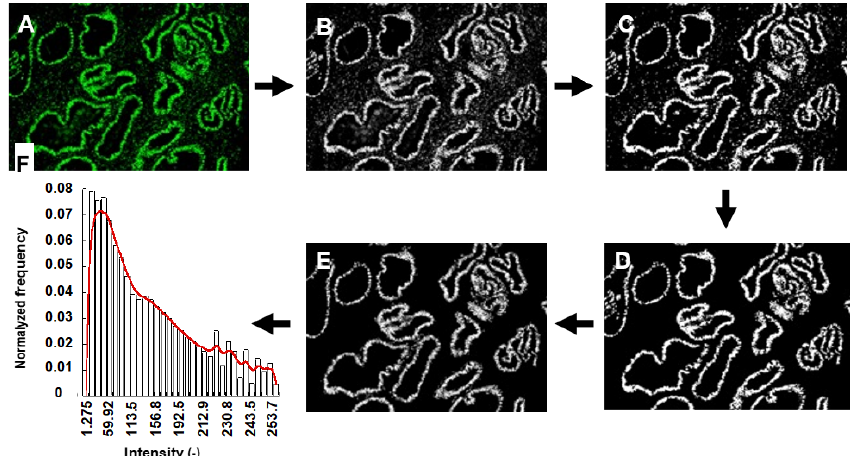
Figure 1. Image processing workflow to quantify epithelial endometrial BCL6 expression: ( A ) original image of one isolated region from the whole scanned image registered in RGB space, ( B ) grey level green component of the RGB image ( C ) automatic thresholding to extract all BCL6 expression (green labeling in stromal and epithelial compartments), ( D ) resulting binary image after filtering stromal cells, ( D ) visualization of the resulting image in 256 gray levels) after background elimination by multiplying the binary image with the grey level green component, ( E ) resulting intensity distribution, ( F ) Histogram of intensities.